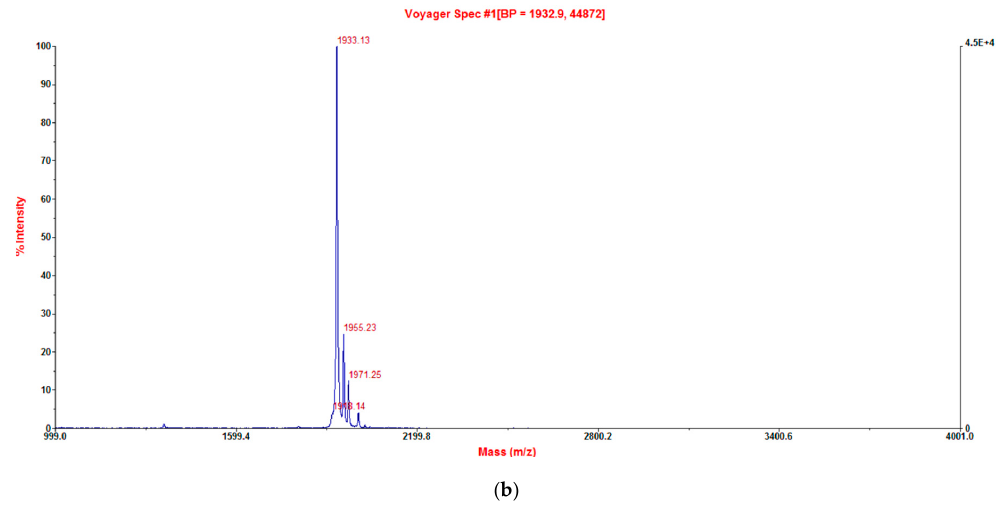
Figure 5. The ( a ) RP-HPLC chromatogram and ( b ) MALDI-TOF MS spectrum of the purified synthetic phylloseptin-PTa.